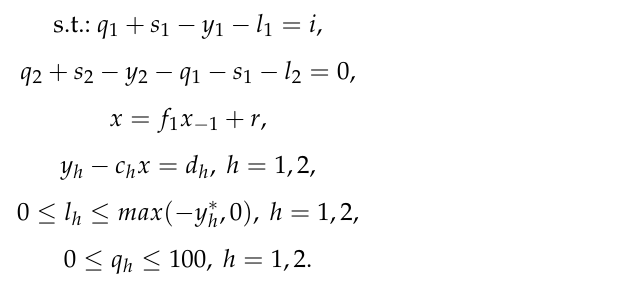
Figure 4. Cost function ( 𝑧 (cid:3016)(cid:3023) ) (10 3 $) per inflow (hm 3 ) with the optimality cuts (orange) approximat- ing the cost function. 2.2. Penalty In the penalty approach, a slack variable is included to assume the exact value to eliminate the inflow’s negativity, and it is penalized in the objective function. Therefore, 𝑧(𝑖, 𝑥 (cid:2879)(cid:2869) ) receives a new element that penalizes ( 𝑙 (cid:3035) ): 𝑧 (cid:3017) (𝑖, 𝑥 (cid:2879)(cid:2869) ) = min 50𝑝 (cid:2869) + 100𝑝 (cid:2870) + 200𝑝 (cid:2871) + 500𝑝 (cid:2872) + 𝑘 (cid:2869) 𝑙 (cid:2869) + 𝑘 (cid:2870) 𝑙 (cid:2870) ,